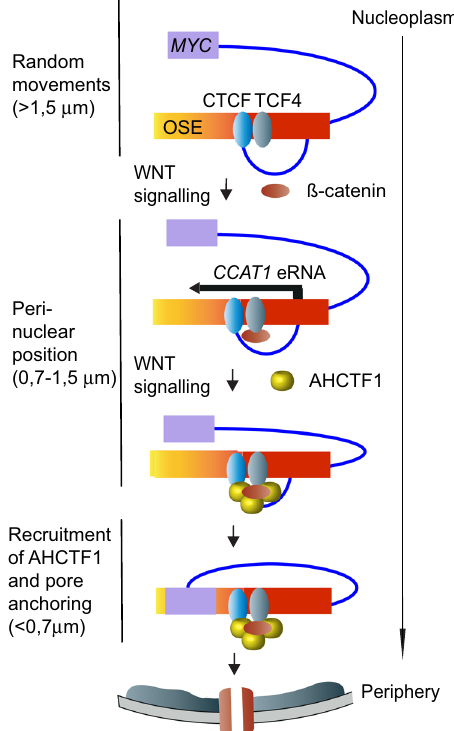
Fig. 7 A model outlining the role of the CTCFBS to effectuate the WNT- controlled stepwise traf fi cking of MYC to the nuclear pore. The migration of the OSE to the nuclear periphery/pore is postulated to occur in three phases: one initially random movement of the OSE in the nuclear interior is followed by a preferential localization of the OSE to a position close to the periphery. This process correlates with WNT-induced activation of CCAT1 transcription, mediated by the CTCFBS potentially in collaboration with the fl anking TCF4 motifs. A third key event is the recruitment of AHCTF1 to the CTCF-complexed OSE, which likely occurs close to the periphery in positions illustrated by proximities between CTCF and AHCTF1. Importantly, this last step is critical for the ability of the OSE to reach the nuclear pore. Prior to the anchoring of MYC to the nuclear pore, the potential for direct interaction between the OSE and MYC is highest within 0.5 μ m from the nuclear pore, paralleled by declining CCAT1 transcription. This entire process is strongly reduced or absent in mutant D3/E4 HCT-116 cells or normal human primary colon epithelial cells in which the region corresponding to the OSE is unable to ef fi ciently bind